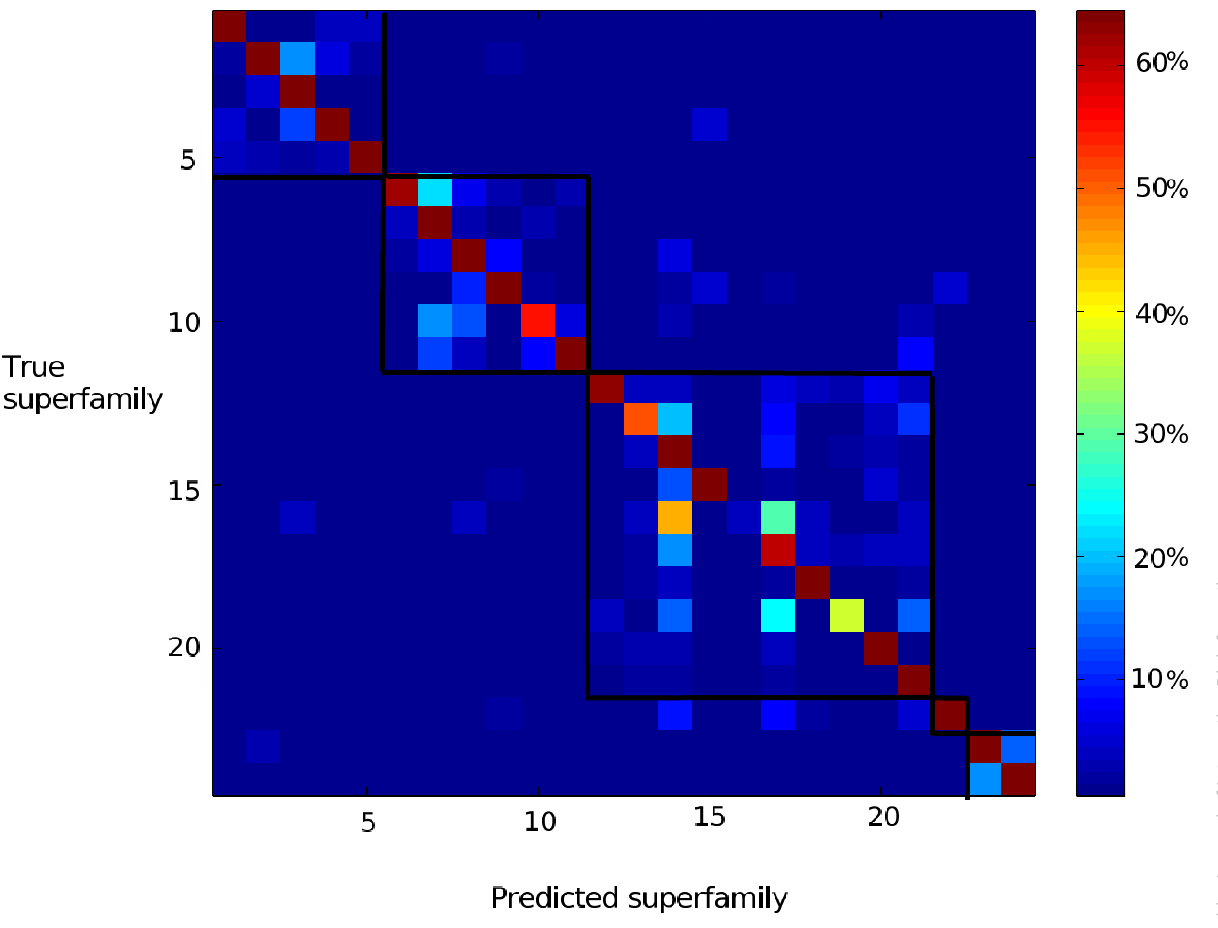
Figure 4: Superfamily confusion matrix produced by the SVM model enriched at 30% sequence identity (excluding multi domain proteins). Each small square represents the percentage of do- mains belonging to the superfamily on the y axis (true superfamily) that were predicted to belong to the superfamily on the x axis (predicted superfamily). The colour of each square relates to the predicted percentage of total instances according to the colour ramp on the right of the matrix. Black bordered squares represent the 5 classes that the 24 superfamilies are grouped into. This figure highlights the fact that when a domain is miclassified at the superfamily level, it is usually correctly assigned at the class level within the SCOP